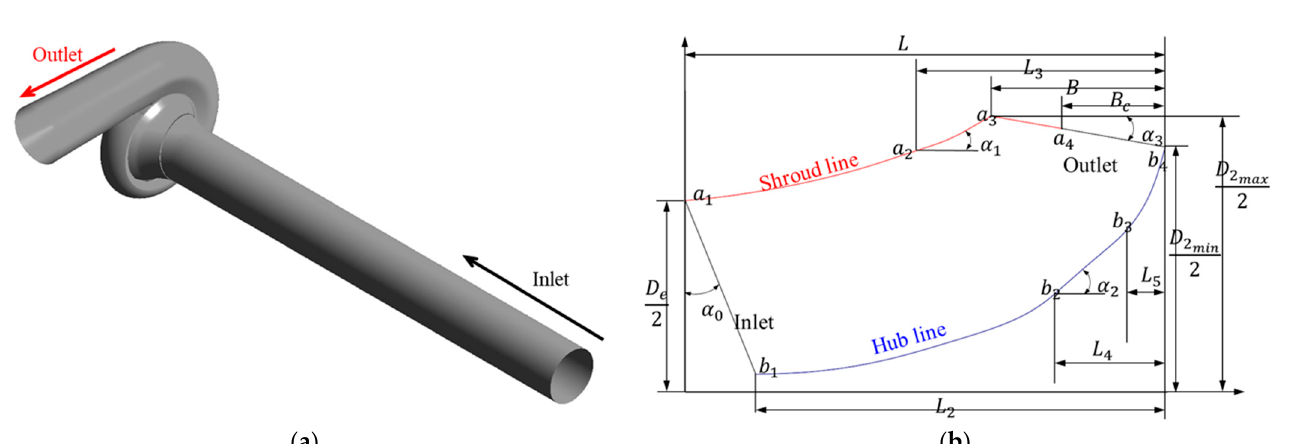
Figure 5. Schematic view of J-Groove shape parameters in screw centrifugal pump model. Table 3. Shape parameters of J-Groove for AJP and SCP models. Nomenclature